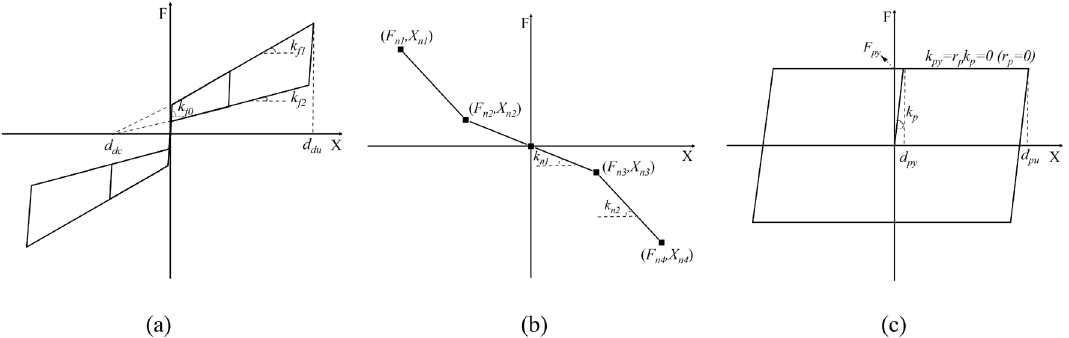
Fig. 8 Parameters defining adopted 3 link components in